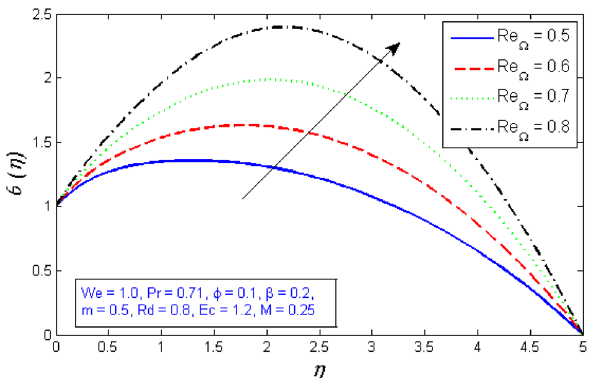
Figure 19. Represents variation of temperature distribution for several number of Local Reynolds number based on the disc angular velocity Re (cid:31) .